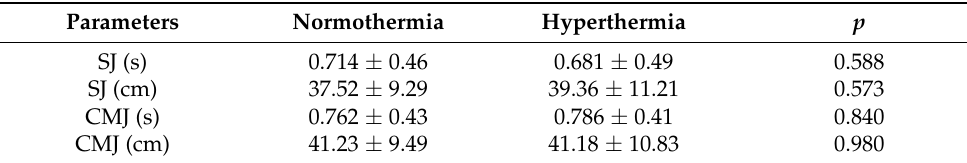
Table 3. Vertical jump